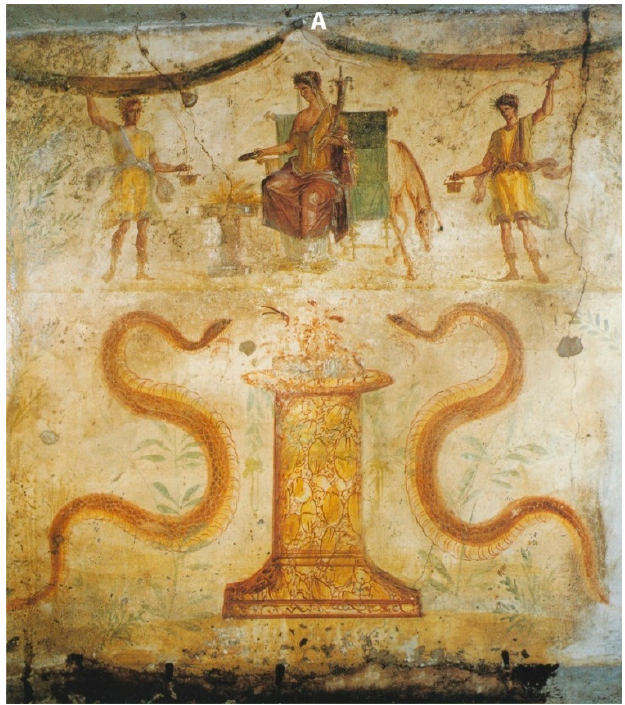
Figure 9. Bakery (7.12.11), Pompeii. Lararium with Vesta, lares , and snakes approaching an altar. Central hole for garland indicated by letter ( A ). (Modified by author, after Fröhlich 1991, Taf. 1).